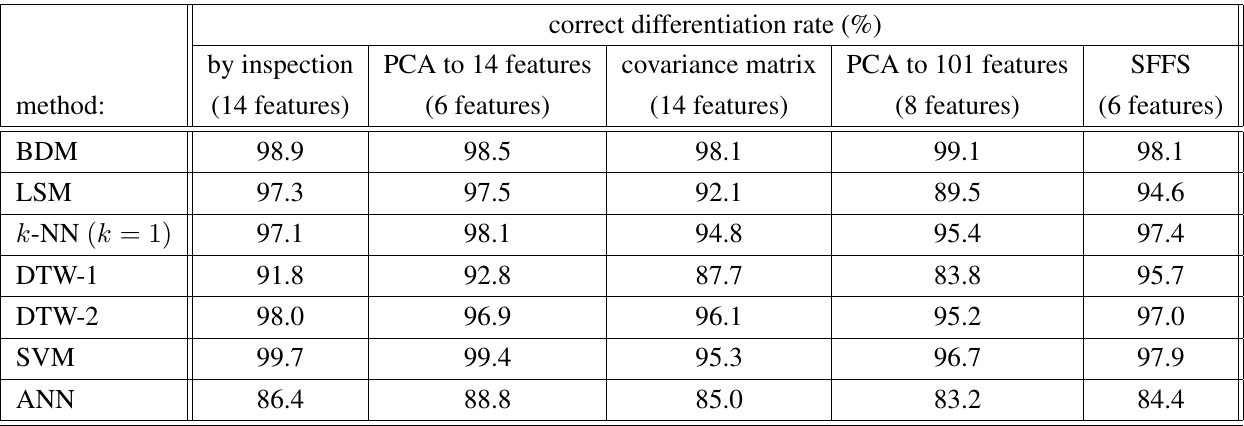
Table 4. Correct differentiation rates for different feature reduction methods and P -fold cross validation.